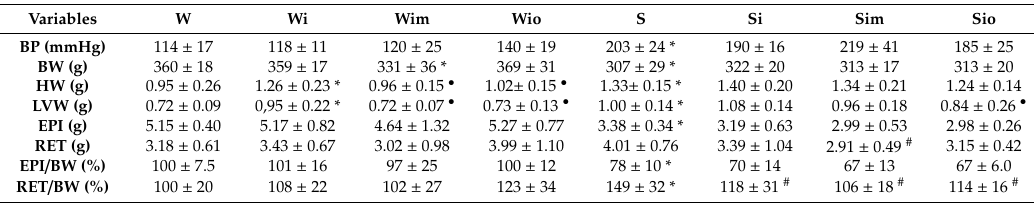
Table 2. General characteristics of experimental